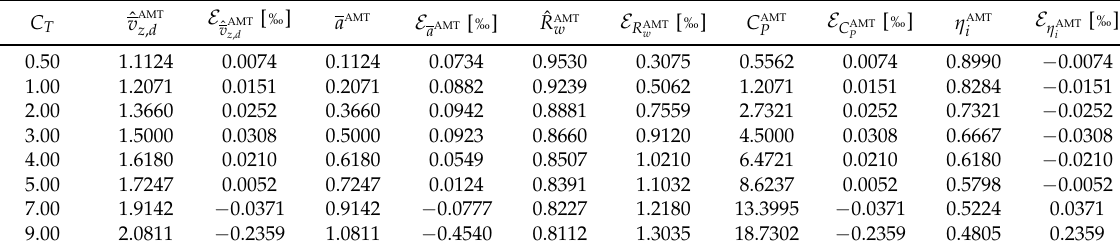
Table 1. Verification of the free-wake ring-vortex actuator disk